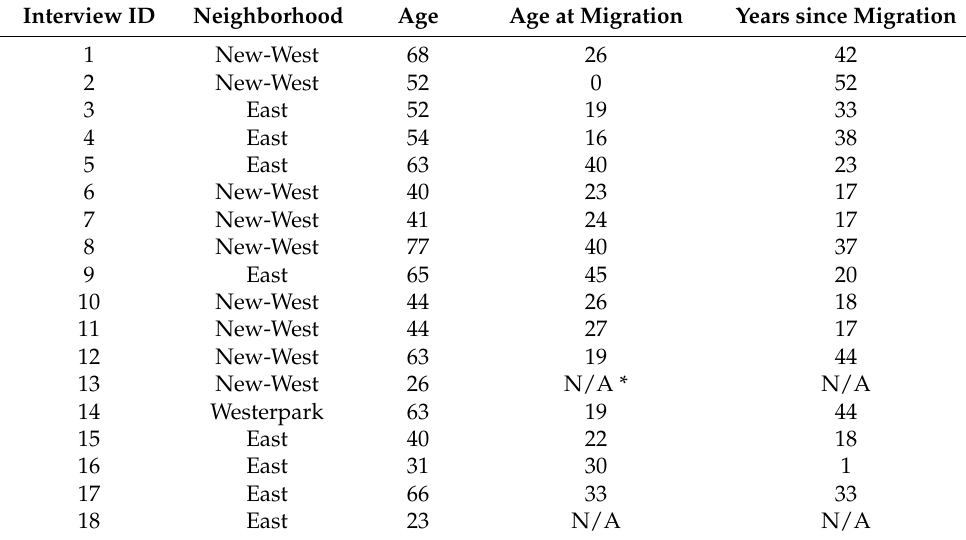
Table 1. Interview participant